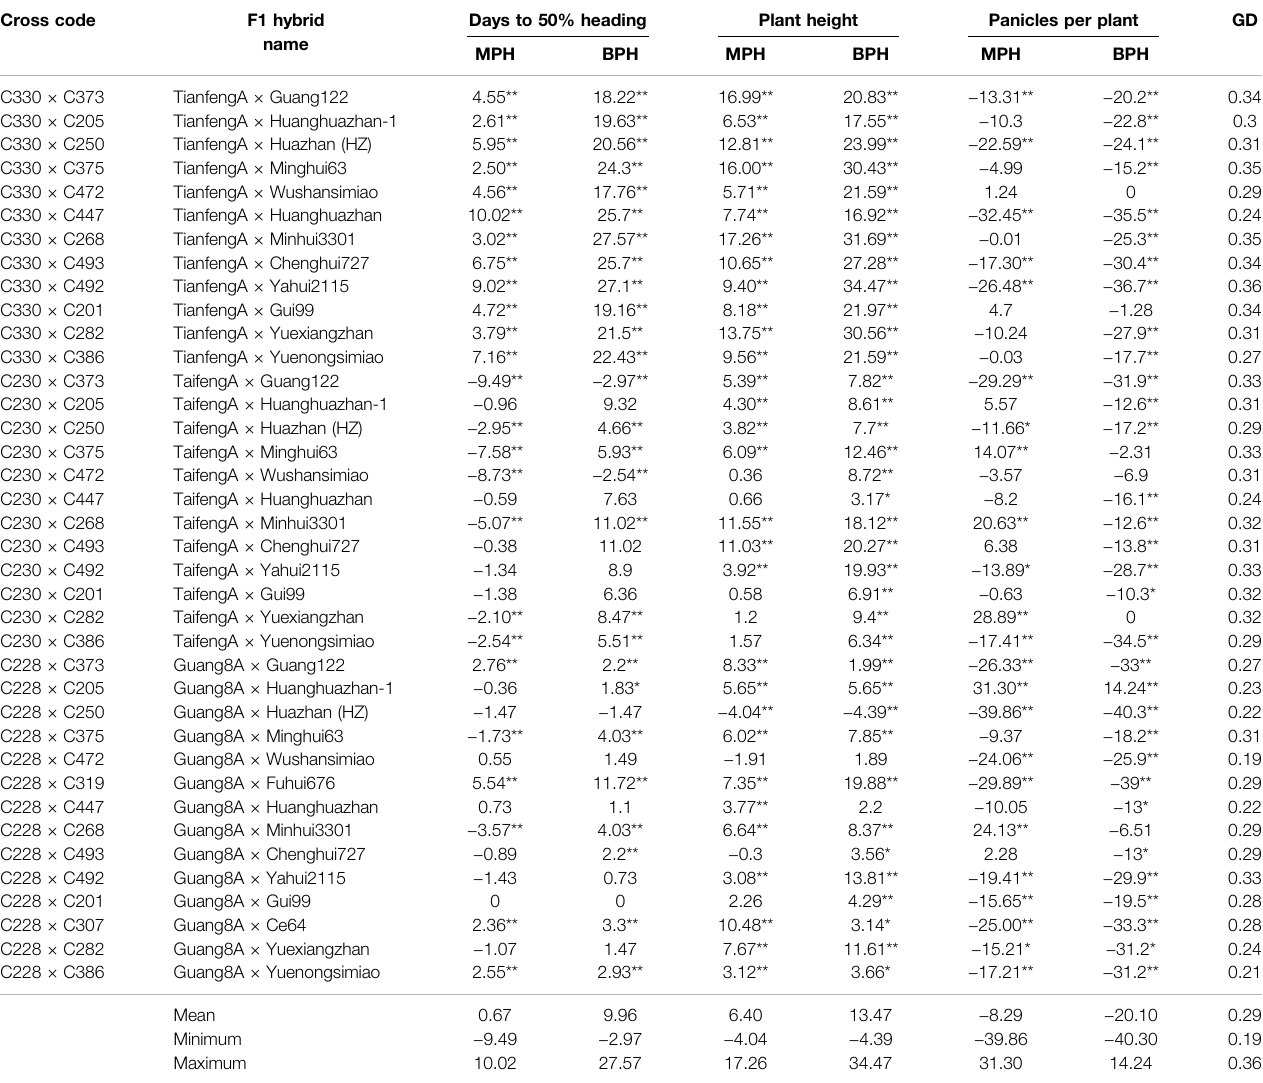
TABLE 4 | Mid-parent and better-parent heterosis estimates for days to 50% heading, plant height, panicles per plant, and genetic distances between their corresponding parents. Cross